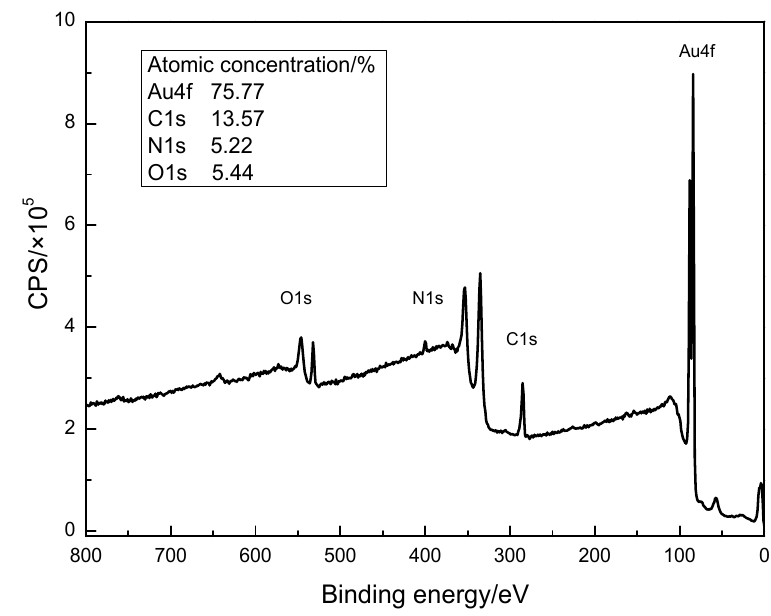
7 of 13 Figure 5. SEM images of the gold surface before and after gold dissolution ( a and c : original gold plate, b : conventional cyanidation, and d : Bi intensification cyanidation). 3.4. Composition Analysis of Surface Products 3.4.1. Surface Product Information Analysis by XPS The gold plates after cyanide dissolution (conventional and Bi intensification) were analyzed by XPS to obtained molecular level product information on the gold surface, and the results of XPS spectra (Au4f, C1s, N1s, O1s, and Bi4f) were shown in Figures 6 and 7. Both XPS spectra were basically the same, except that there was a weak Bi4f peak in Bi intensification, which was caused by the addition of bismuth ions. The similar spectrum means that the surfaces of two gold plates were made up of similar chemical elements. Meanwhile, the relative concentration of elements on the gold surface was shown in Table 2. The content of Au was higher than other elements, indicating that gold was the main element on the surface of gold. The existence of C, N, and O indicates that cyanide forms some products deposited on the gold surface. Compared with the XPS analysis of gold plates under conventional cyanidation, the proportion of Au on gold surface under bismuth intensification was decreased significantly, while the proportion of C, N, and O was increased. The results showed that the rapid dissolution of gold resulted in a relatively small amount of gold on the surface, which was consistent with the results of surface microscopic detection. The deposition of bismuth on the